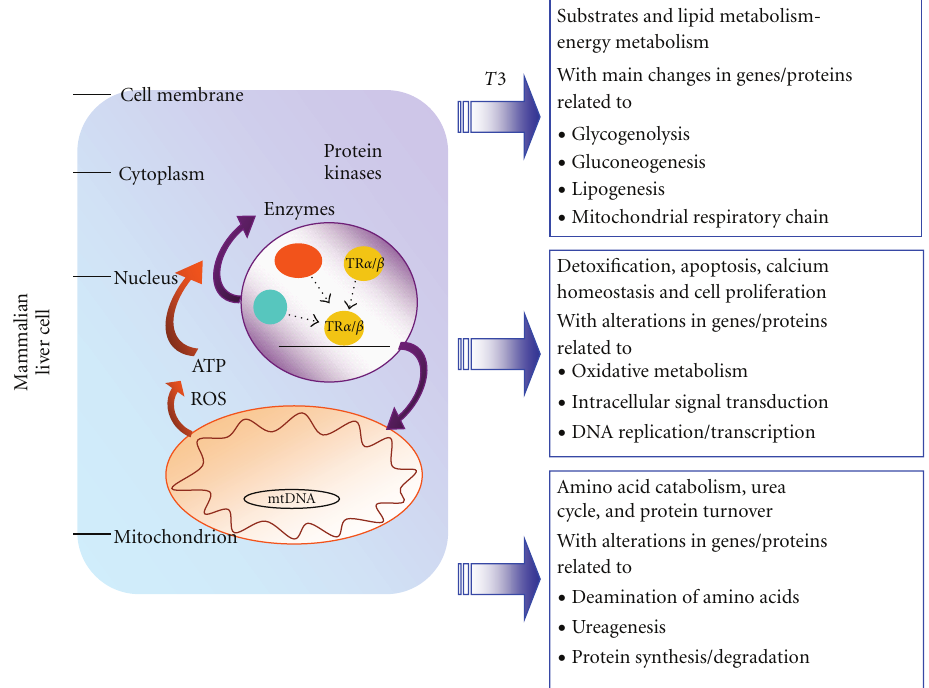
Figure 3: Overview of the main T3-induced transcriptomic and proteomic alterations occurring in mammalian liver. Schematic representation of the alterations in gene/protein expression underlying the response of liver to T3. Schematized are the main events and mechanisms underlying the actions of T3. Summarized are data obtained in cDNA microarray/proteomic-based studies in various mammalian models (mouse, rat, and human) (for details, see text and Tables 3 and